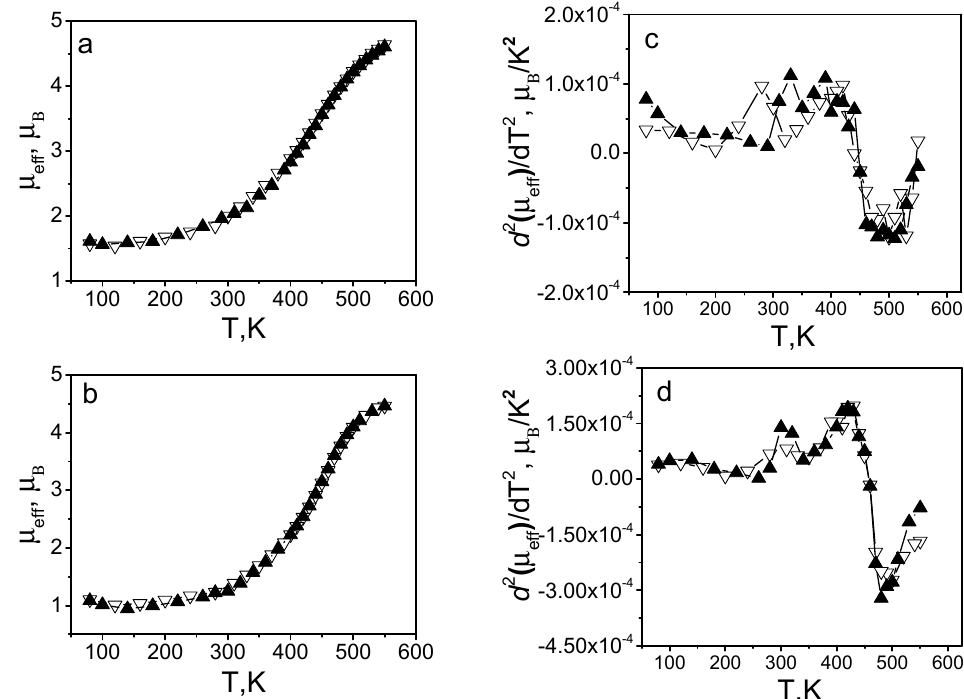
Figure 6. Dependences of μ eff (T) ( a , b ) and d 2 ( μ eff (T))/dT 2 ( c , d ) for dehydrated complexes 4 ( a , c ), 5 ( b , d ). The white and black triangles in the figure correspond to the samples cooling and heating processes respectively.